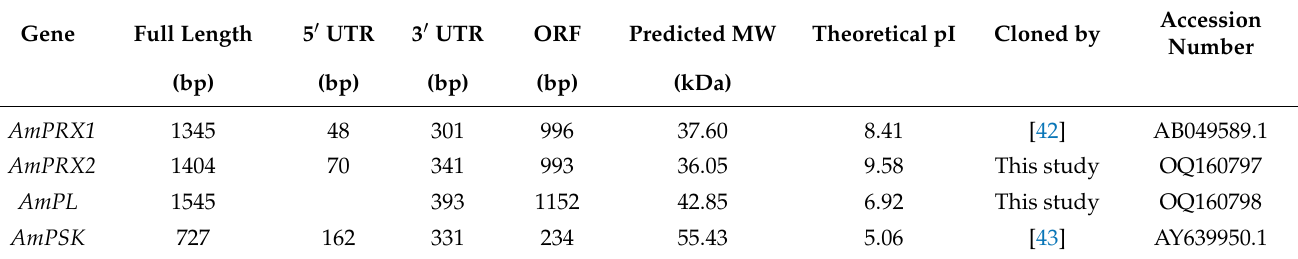
Table 1. Characteristics of genes associated with trace metal tolerance in Avicennia marina